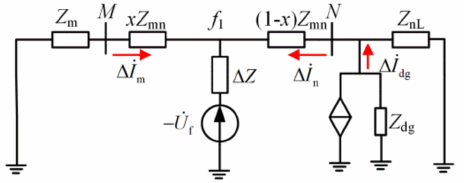
Figure 3. Positive–sequence fault component composite sequence network with